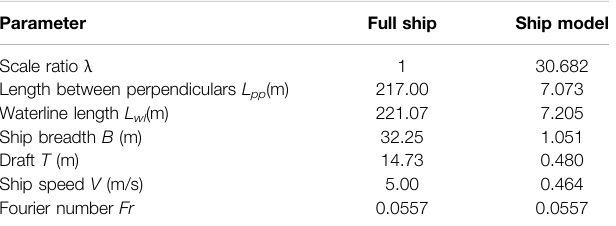
TABLE 1 | Main parameters of the ship model.